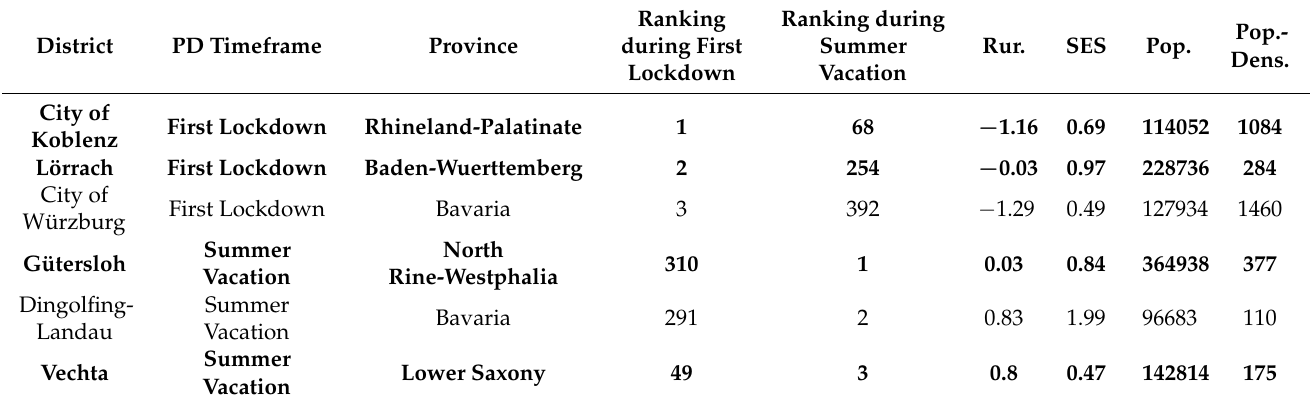
Table 3. Structural properties of the PD candidate districts. Names of those districts whose administration participated in a focus group discussion are in bold . Rur.—ruralness, SES—socioeconomic status, Pop.—population, Pop.-Dens.—population density (inhabitants per km 2